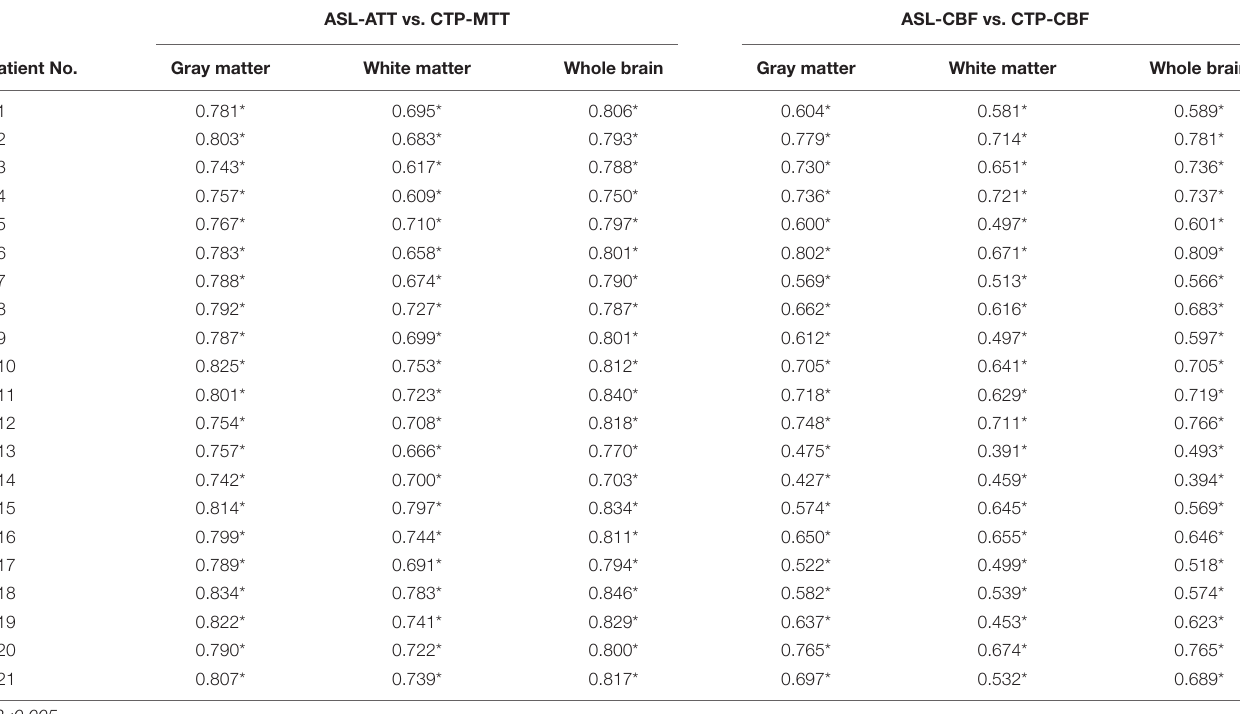
TABLE 2 | Pearson correlation coefficients between the two modalities in gray, white matter and whole brain of each subject. ASL-ATT vs. CTP-MTT ASL-CBF vs. CTP-CBF Patient No.